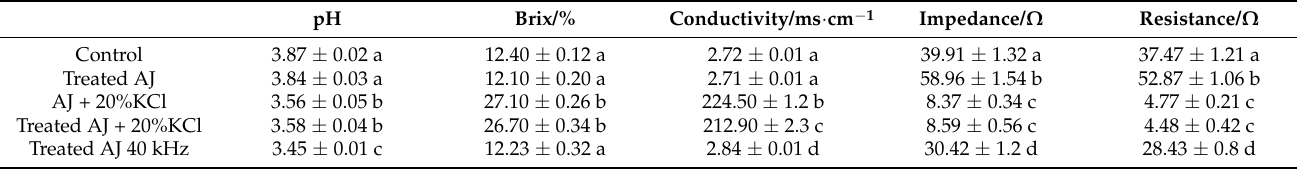
Table 3. Physical properties of the samples after IEF